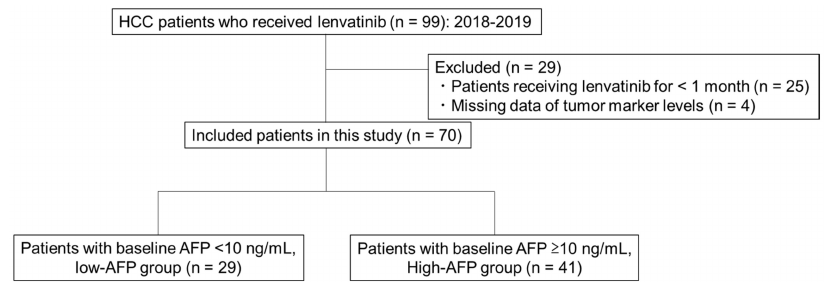
Figure 2. Study chart. In total, 99 patients were treated with lenvatinib at various centers. Of them, 70 patients met the inclusion criteria. They were divided into the high-alpha-fetoprotein (AFP) group (baseline AFP ≥ 10 ng / mL; n = 41) and the low-AFP group (baseline AFP < 10 ng / mL; n = 29).